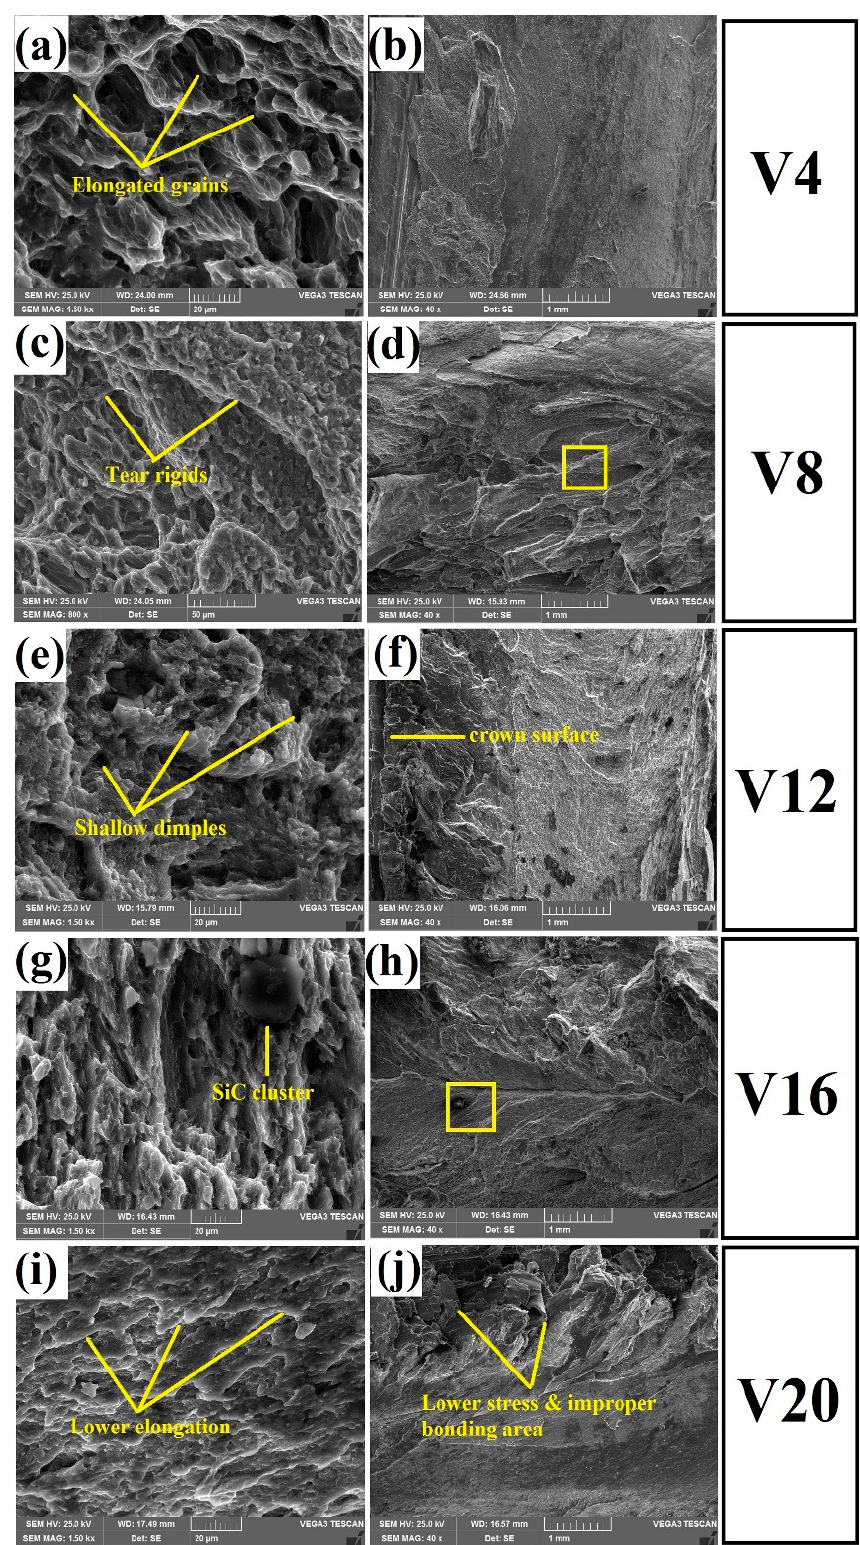
Figure 14. SEM fractography of the tensile specimens with macrographs of ( a,b ) V4—high and low low magnification; ( c , d ) V8—high and low magnification; ( e , f ) V12—high and low magnification; magnification; ( c,d ) V8—high and low magnification; ( e,f ) V12—high and low magnification; ( g,h ) ( g , h ) V16—high and low magnification; ( I , j ) V20—high and low V16—high and low magnification; ( I,j ) V20—high and low magnification.